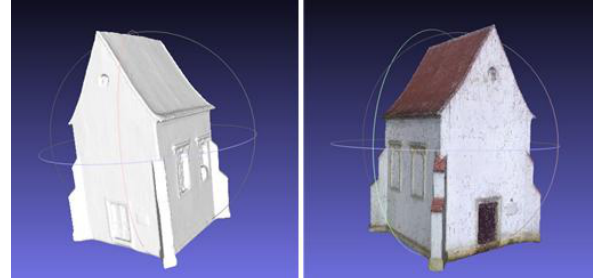
Figure 6: 3D modelling of a building in Meshlab